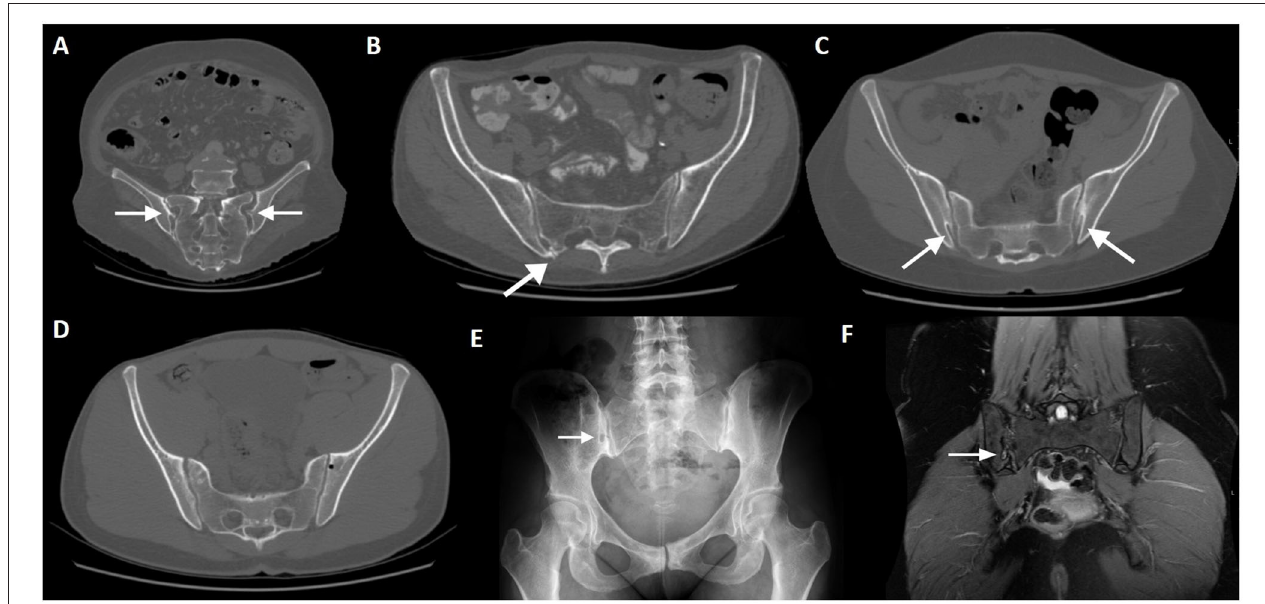
FIGURE 3 | Normal variants and incidental findings of the sacroiliac joint (arrows). CT reconstructions with oblique orientation depict bilateral iliosacral complexes (A) , the most common sacroiliac joint variant; right accessory sacroiliac joint (B) ; bilateral bipartite iliac bony plate (C) ; left iliac bone pneumatocyst (D) . A patient with an incidental finding on the right sacroiliac joint seen on pelvic radiography performed MRI, which revealed an iliac bone cleft filled with fluid (E,F) . Note the sclerosis of the symphysis pubis (E) , compatible with osteitis pubis